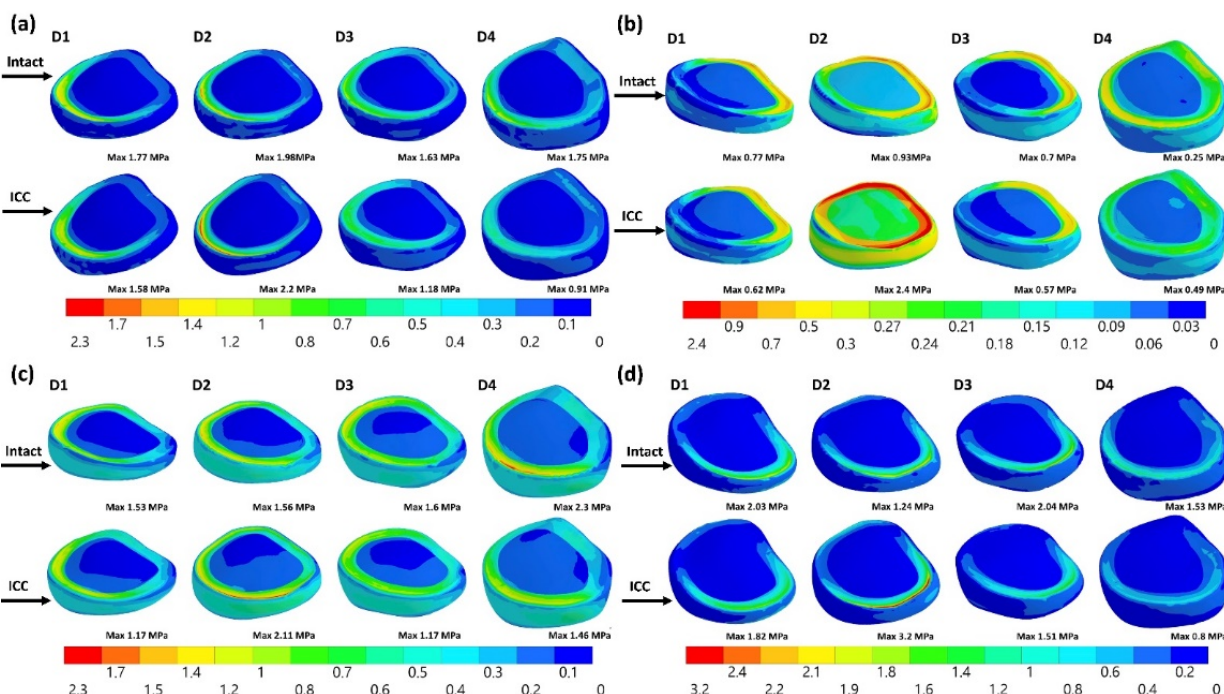
Figure 8. The results of the annular ground substance stress.